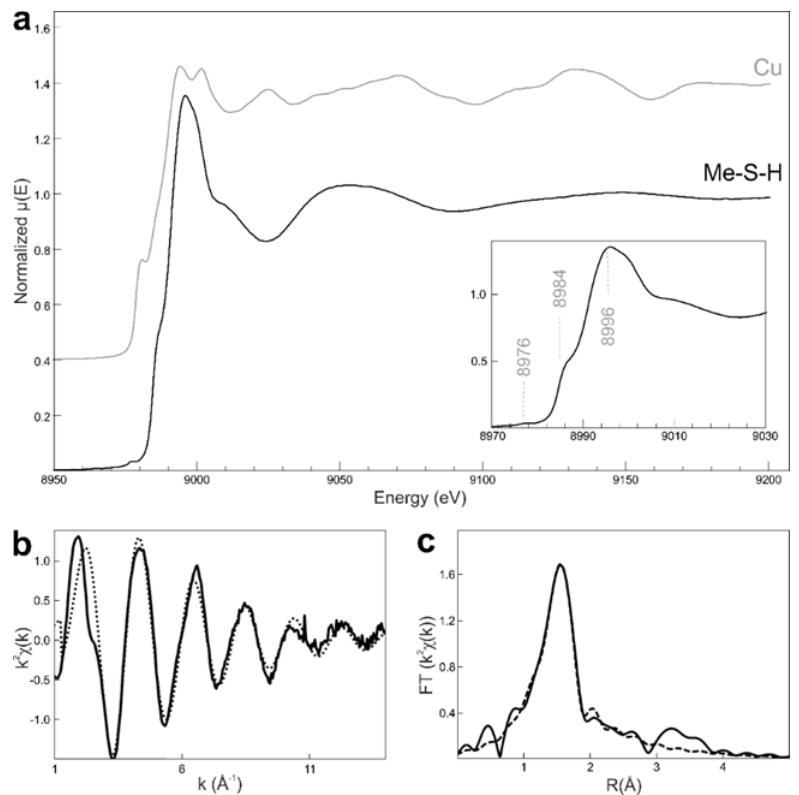
Figure 4. ( a ) Copper K-edge normalized spectrum of Me-S-H. A limited energy range is displayed to emphasize the XANES region. The normalized spectrum of Cu foil is reported for comparison. In the inset, a magnification of the Me-S-H spectrum to highlight the pre-edge and edge features ( b ) K 2 -weighted EXAFS signal at Cu k-edge and ( c ) magnitude of the corresponding Fourier transform (right). Solid lines are the measured signal; dotted lines are the fitted signal. Table 1. Structural parameters obtained from Cu K-edge data analysis. Numbers in parenthesis: estimated uncertainties. N: number of atoms; S 02 passive electron reduction factor; R: interatomic